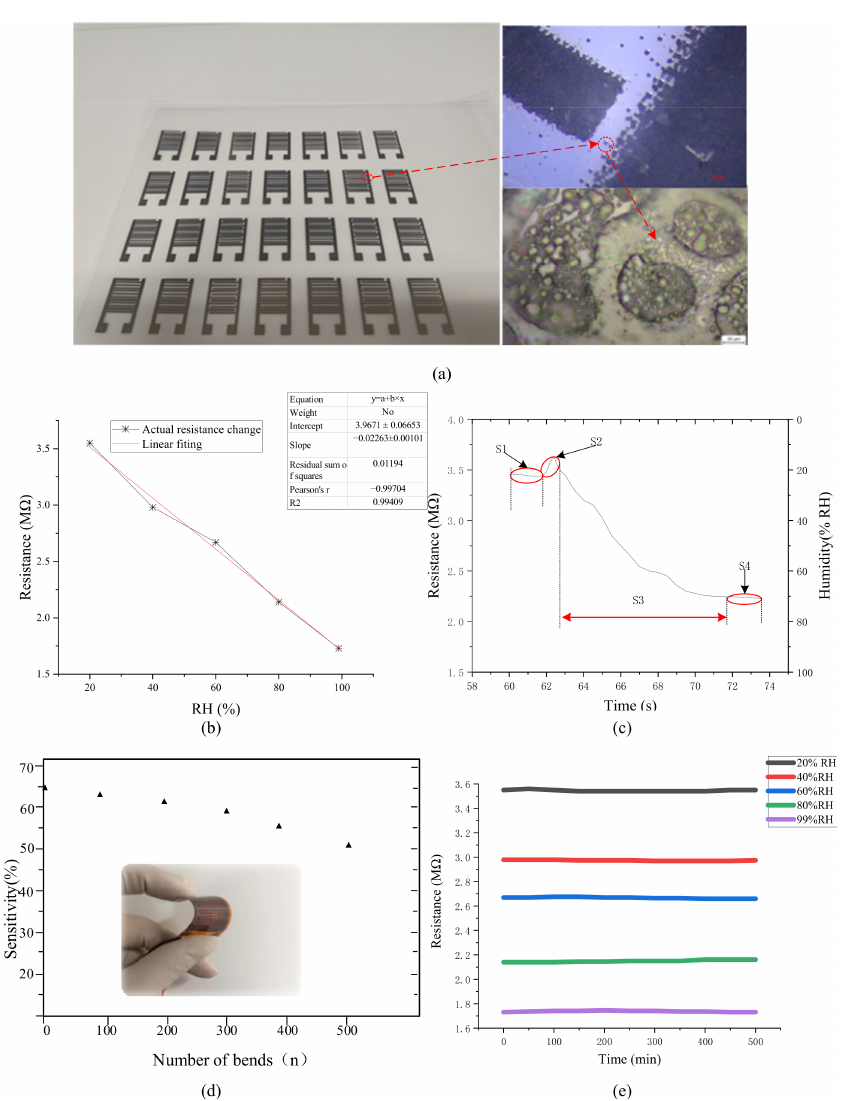
Figure 3. Sensor performance evaluation: ( a ) Sensor microstructure characterization; ( b ) Sensor static characteristic test; ( c ) Sensor dynamic response characteristic test; ( d ) Sensor flexibility test; ( e ) Sensor stability